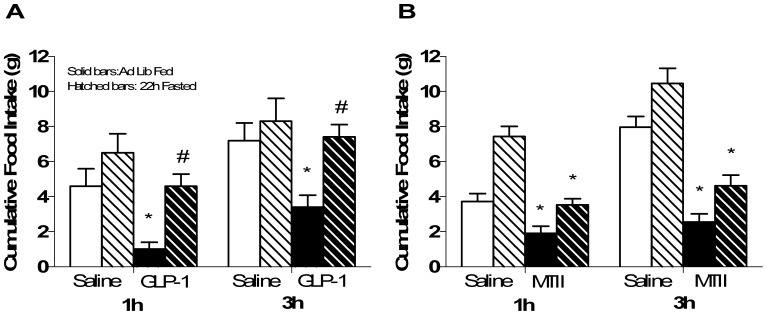
Food intake after i3vt GLP-1 or MTII or saline in fed or fasted animals.a) i3vt GLP-1 suppressed food intake in ad lib (solid bars) fed but not 22 h fasted(hatched bars) animals. *p<0.05 i3vt GLP-1 vs. saline within the ad lib animals; #p<0.05 i3vt GLP-1 fasted vs. ad lib fed animals. b) 1 and 3 h food intake was equally suppressed after i3vt melanotan II (MTII) in ad lib fed and fasted for 22 h. *p<0.05 vs. ICV saline in both fed and fasted groups.